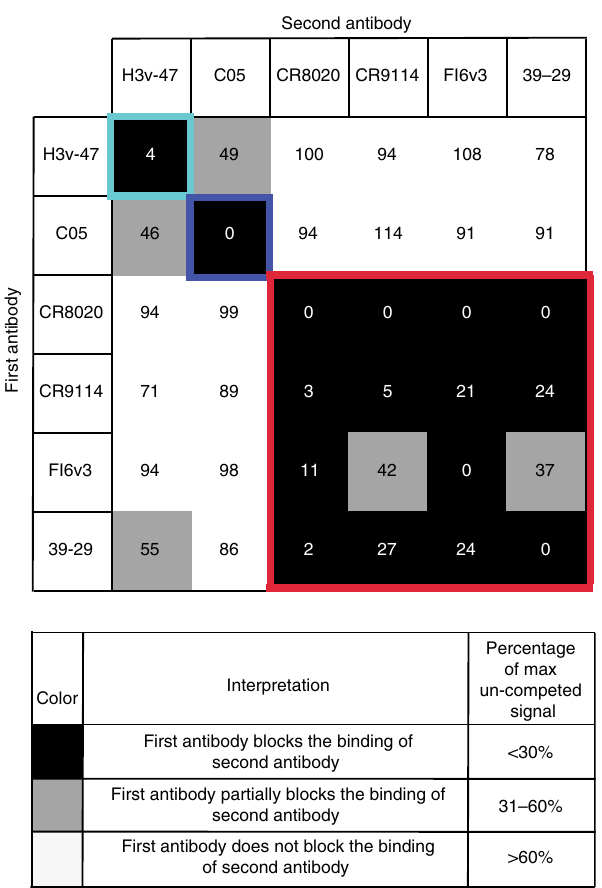
Fig. 2 Competition binding of H3v-47 with other in fl uenza head- or stem- binding antibodies. Competition-binding assays were performed using biolayer interferometry. The His-tagged A/Minnesota/11/2010 H3N2v HA was loaded onto Ni-NTA tips, and binding of two successively applied antibodies (IgG) was tested. MAb H3v-47 was competed against mAb C05, a receptor binding site mAb or each of four stem-binding antibodies: CR8020, CR9114, 39.29, or FI6v3. Numbers indicate normalized percent level of association to HA, compared to uncompeted control (100%). The colored boxes indicate each competition-binding group. There was partial overlap between group 1 and 2, shown in cyan and blue, respectively. indicated in the red competition-binding group box. The experiment